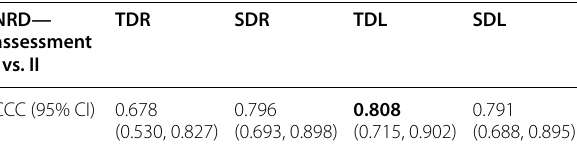
Table 2 Intra-rater agreement in MRI assessment of the